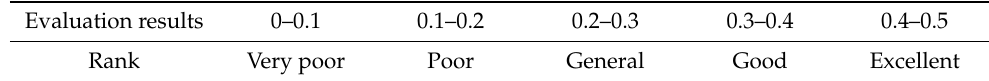
Table 5. The rank of evaluation